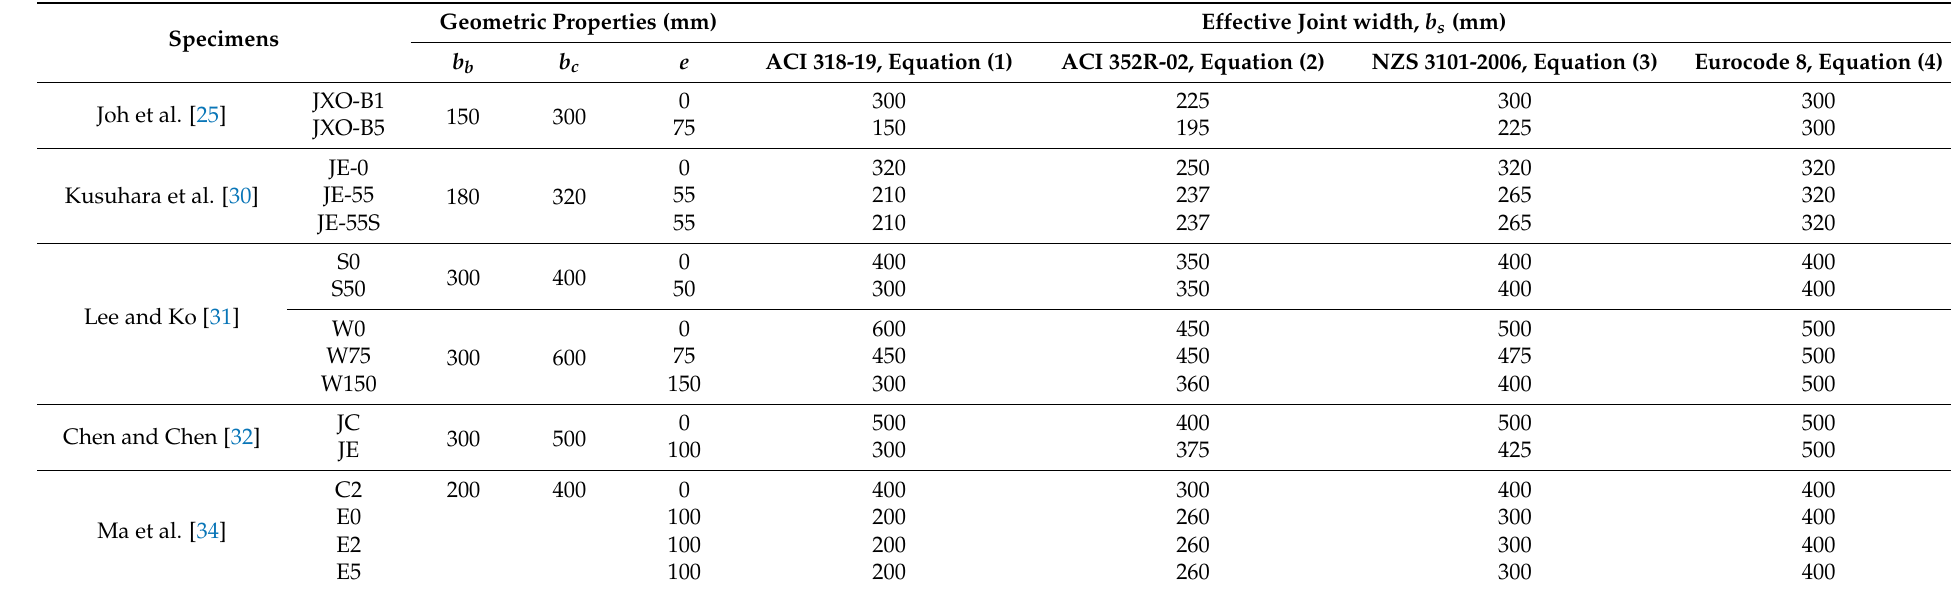
Table 3. Calculated effective joint widths for existing test